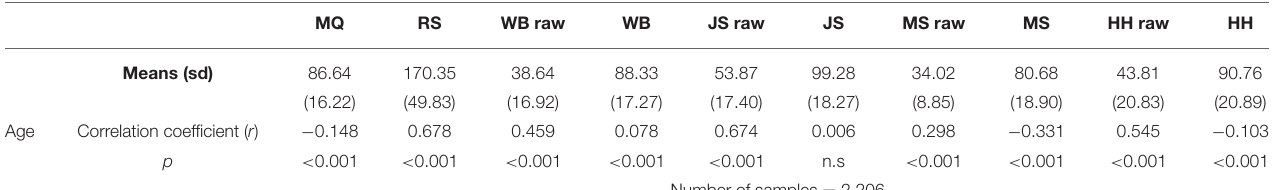
TABLE 2 | Means and standard deviation of all parameters of the KTK (RS, MQ, WB raw, WB, MS raw, MS, JS raw, JS, HH raw, and HH) and their “Spearman rank order correlation” with